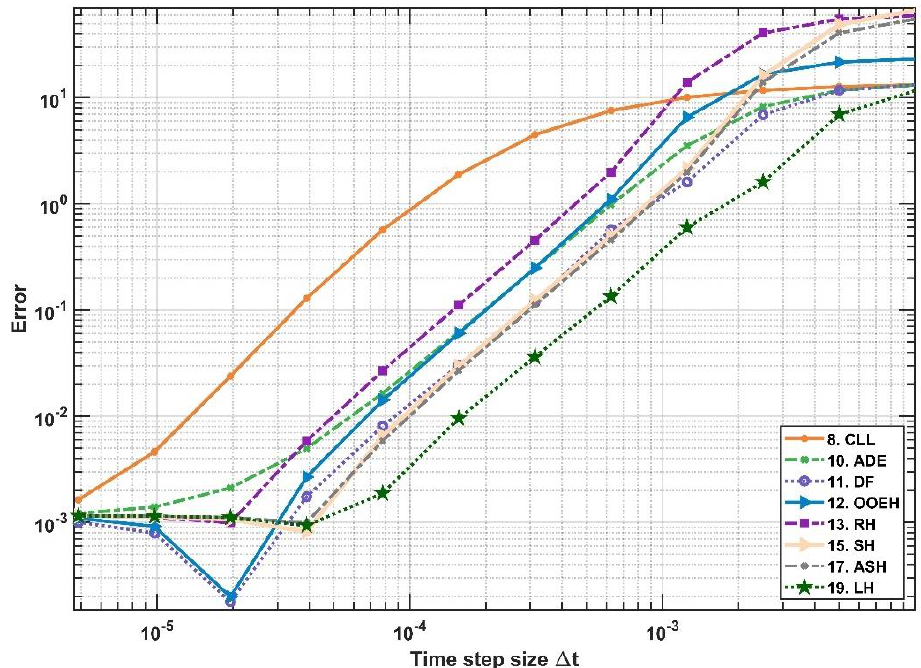
Figure 16. The maximum errors as a function of the time step size ∆ t for the fast convergent numerical schemes in the case of Experiment 6.